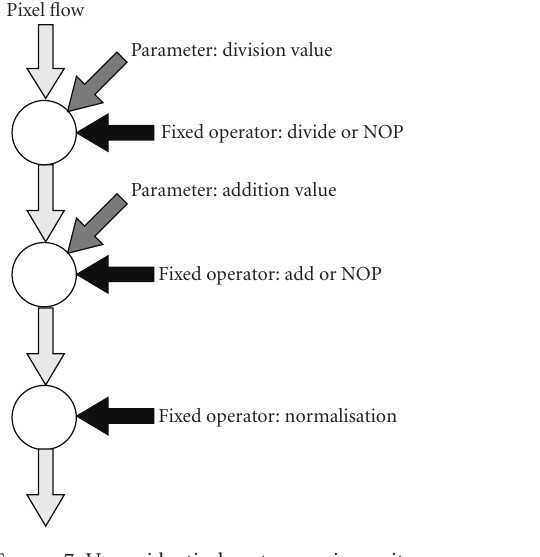
Figure 7: Unary identical postprocessing units.